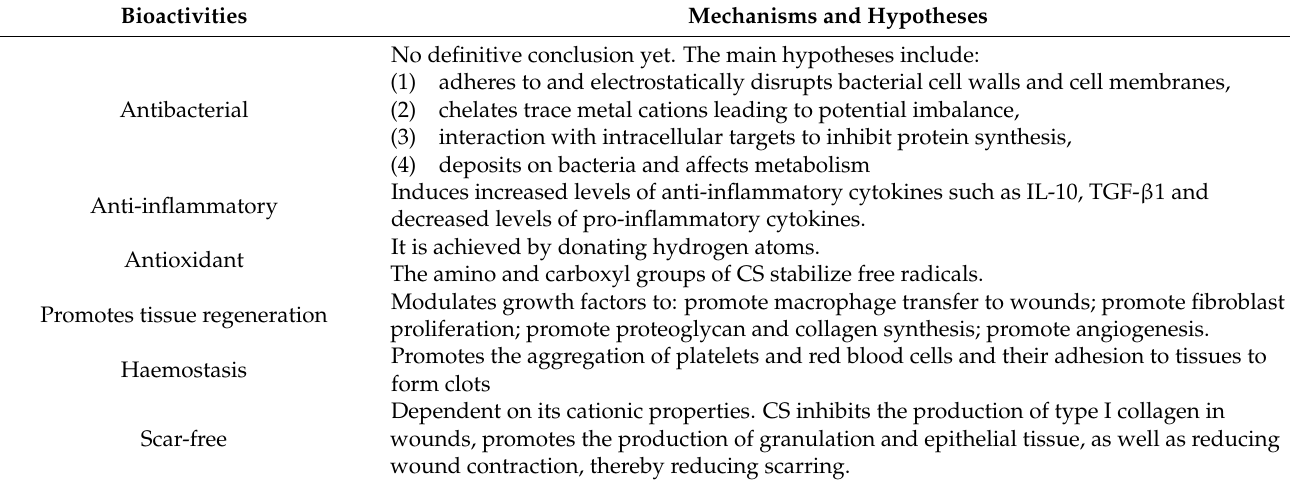
Table 3. Bioactivities of CS that facilitate wound healing and their mechanisms.